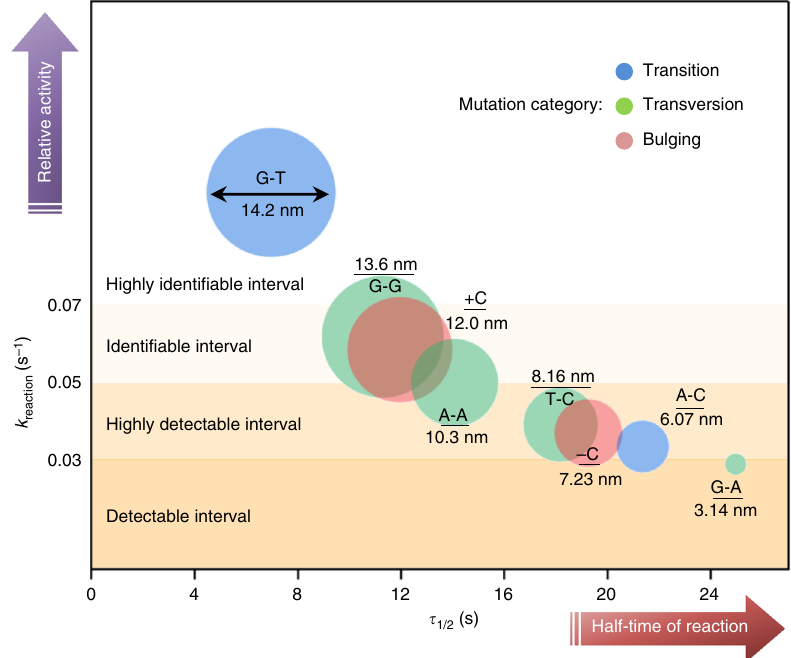
Fig. 5 Atlas of MutS af fi nities to different point mutations. The atlas was established by single Au-bridged nanoparticle (NP) sensing a countable number of binding events between MutS and eight different mutations. Source data are provided as a Source Data fi